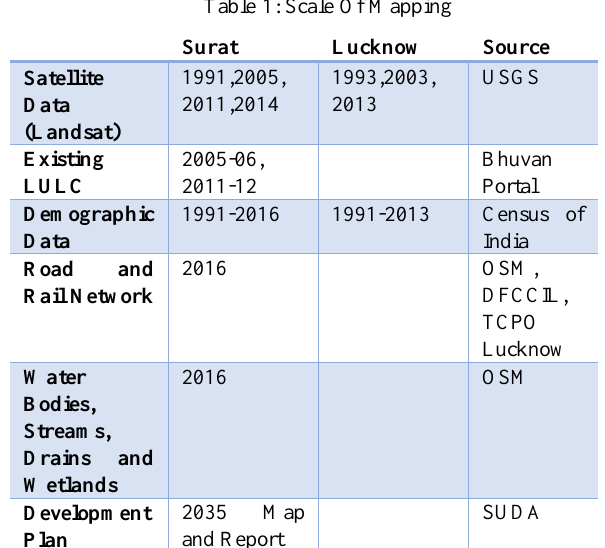
Table 1: Scale Of Mapping